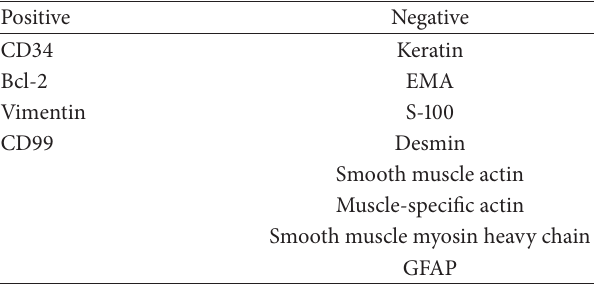
Table 2: Immunohistochemical markers in parotid